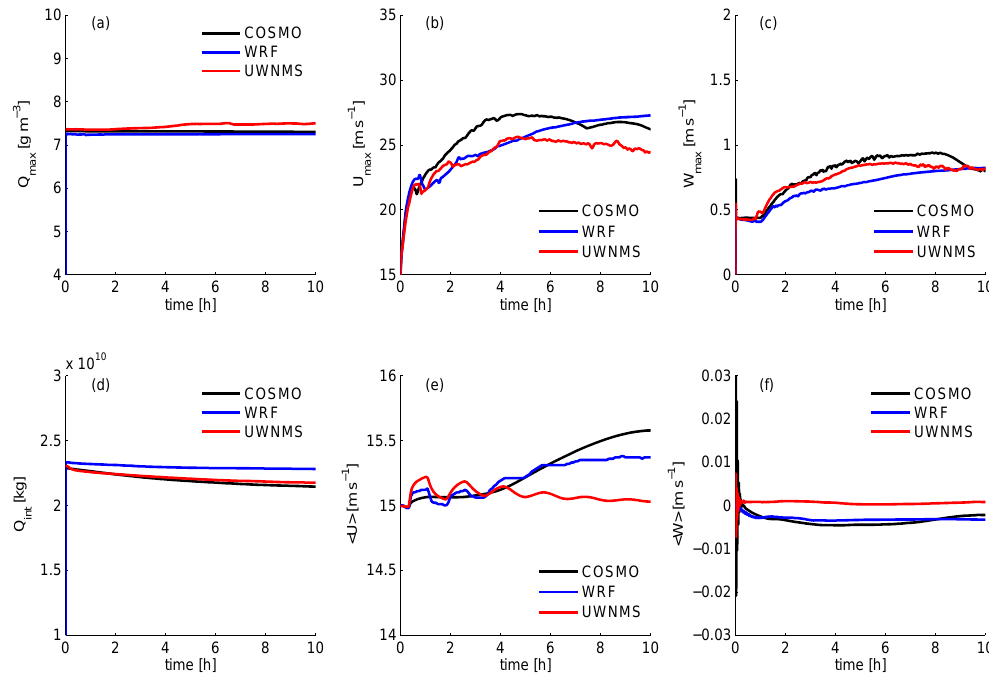
Fig. 3. Time evolution of water vapour, horizontal and vertical wind velocities for simulation SIM 1 CC. The upper panel shows maximum values of specific humidity Q max (a) , horizontal wind speeds U max (b) and vertical wind speeds W max (c) . The lower panel shows domain integrated water vapour Q int (d) , domain average horizontal wind speeds < U > (e) and domain averaged vertical wind speeds < W > (f) . The individual models shown are COSMO (black), WRF (blue) and UWNMS